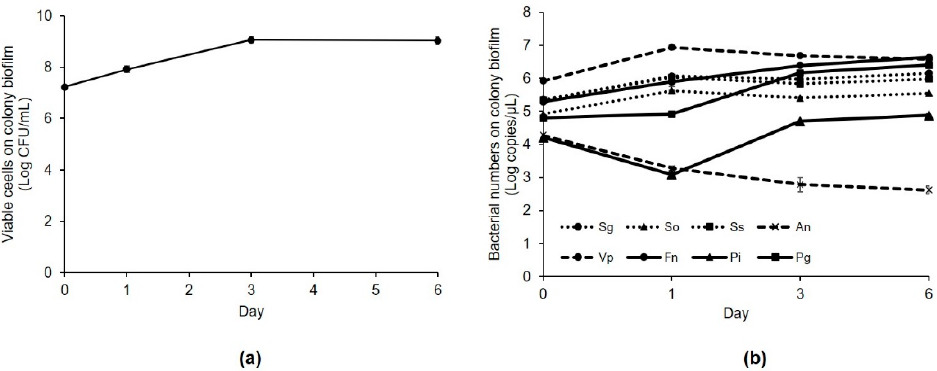
Figure 1. Multi-species colony biofilm formation. ( a ) Number of viable cells in the colony biofilm over time. ( b ) Change in the number of bacteria in the colony biofilm over time measured using quantitative polymerase chain reaction. Sg, S. gordonii ; So, S. oralis ; Ss, S. sanguinis ; An, A. naeslundii ; Vp, V. parvula .; Fn, F. nucleatum ; Pi, P. intermedia ; Pg, P. gingivalis